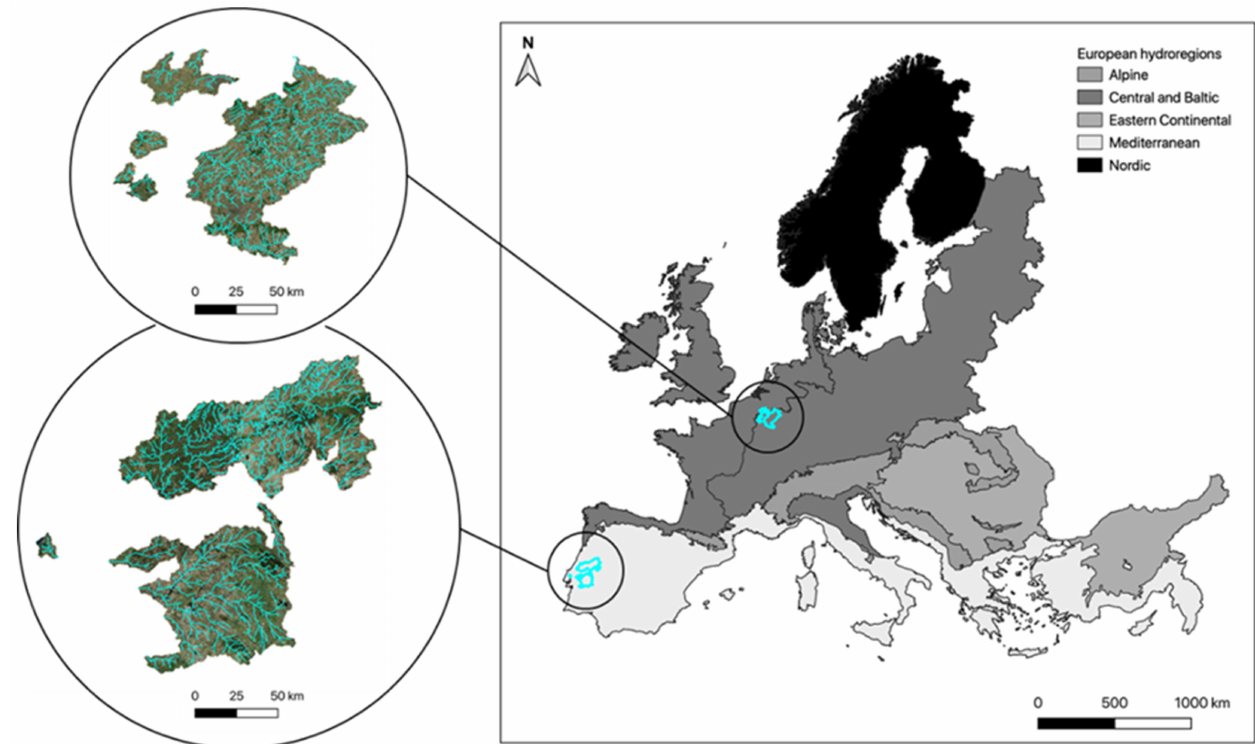
Figure 1. Map of the European hydroregions with the geographic location of the study areas (light blue polygons). Left circular panels show the hydrological network (light blue lines) in the Mediterranean (light grey) and Central Baltic (dark grey)